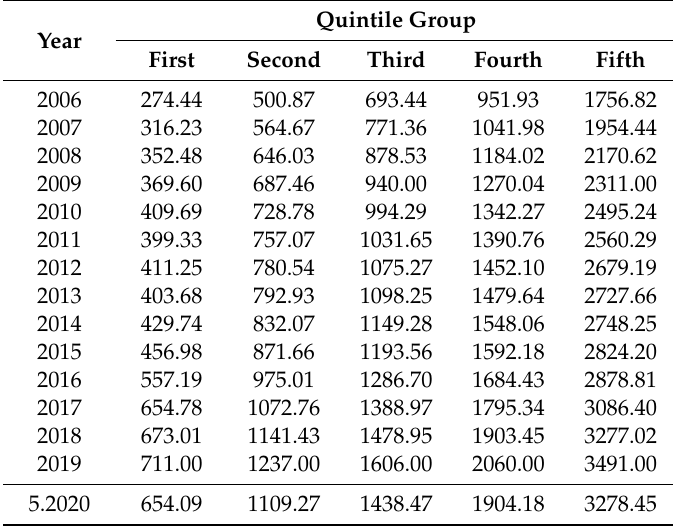
Table 3. Disposable income per capita in Polish households by quintile groups in 2006–2020.